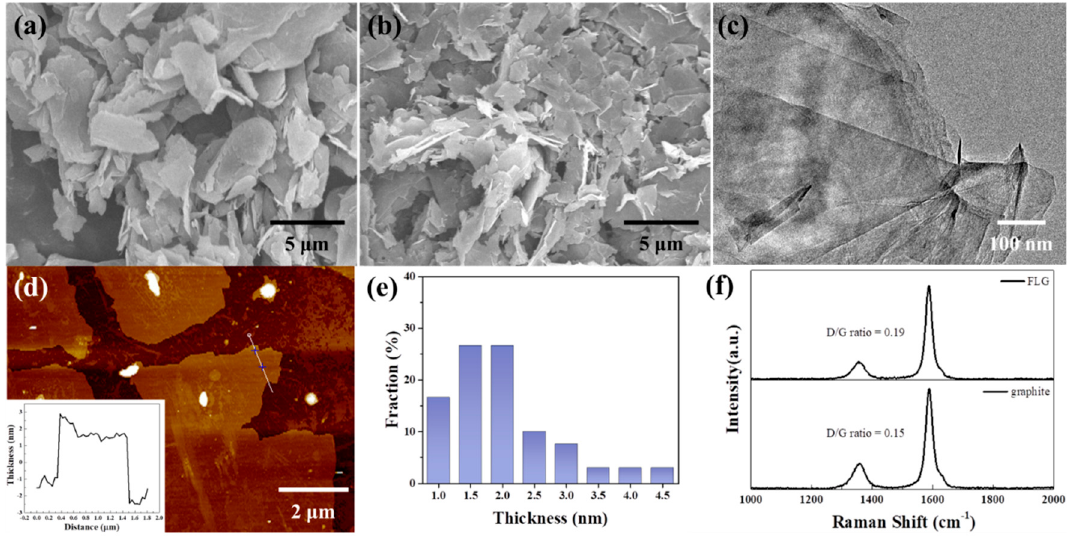
Figure 1. SEM images of ( a ) graphene and ( b ) FLG; ( c ) TEM image of FLG; ( d ) AFM image of FLG, insert: height profiles of FLG; ( e ) thickness distribution of FLG measured by AFM on 35 samples; ( f ) Raman spectra of graphite and FLG.